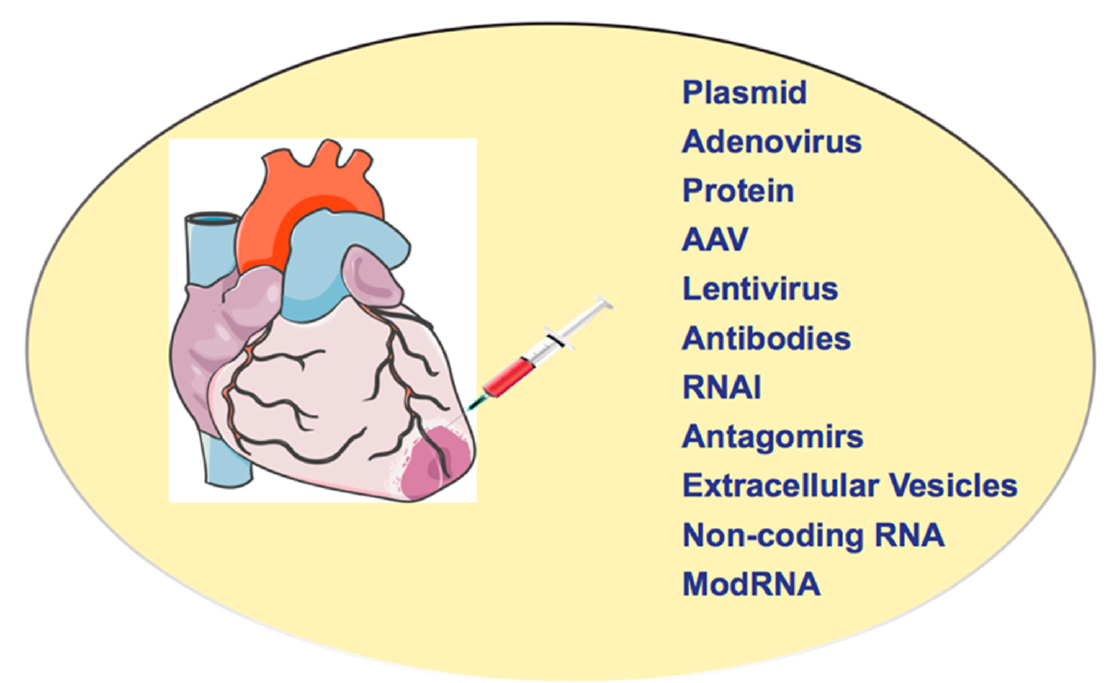
Figure 1. Methods to deliver the genetic material in the heart in vivo. Adenovirus, AAV, lentivirus, recombinant proteins, and antibodies were previously developed to target the heart in animal models and clinical settings. In contrast, RNA-based methods were developed recently, including RNA interference (RNAi and shRNA) (a process where RNA molecules inhibit gene expression or translation by neutralizing targeted mRNA molecules), microRNA (endogenous, a small non-coding RNA molecule (20-22 nucleotides) post-transcriptionally regulate gene expression), non-coding RNAs (ncRNAs) (RNA molecules which do not translate into a protein), antagomirs (chemically synthesized oligonucleotides that inhibit miRNA binding to the desired site on an mRNA molecule), and modRNA. Table 2. Published work showing use of modRNA based gene delivery for heart diseases and regeneration.